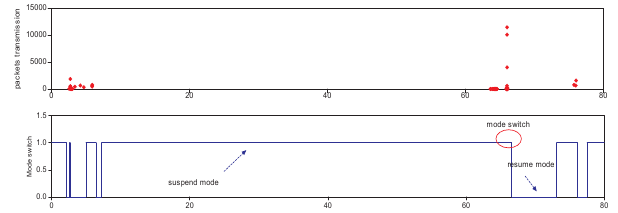
Figure 1. Impact of network transmission behavior on suspend/resume mode switching